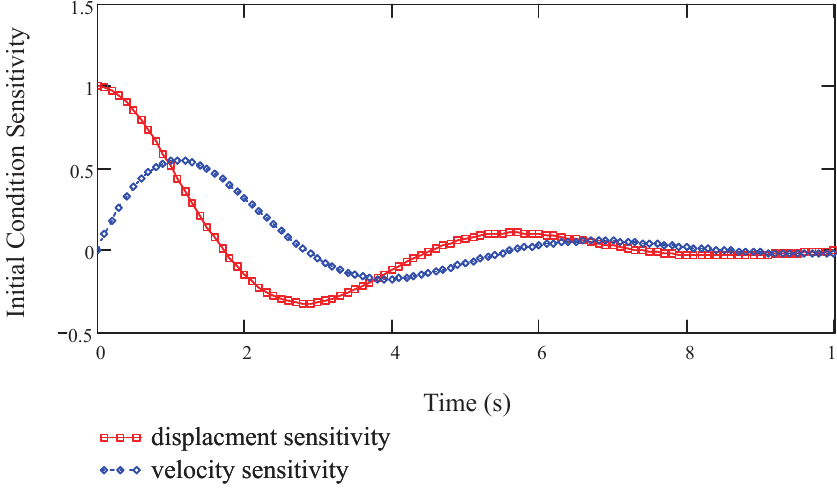
Fig. 6. Model sensitivity to perturbations in initial conditions.